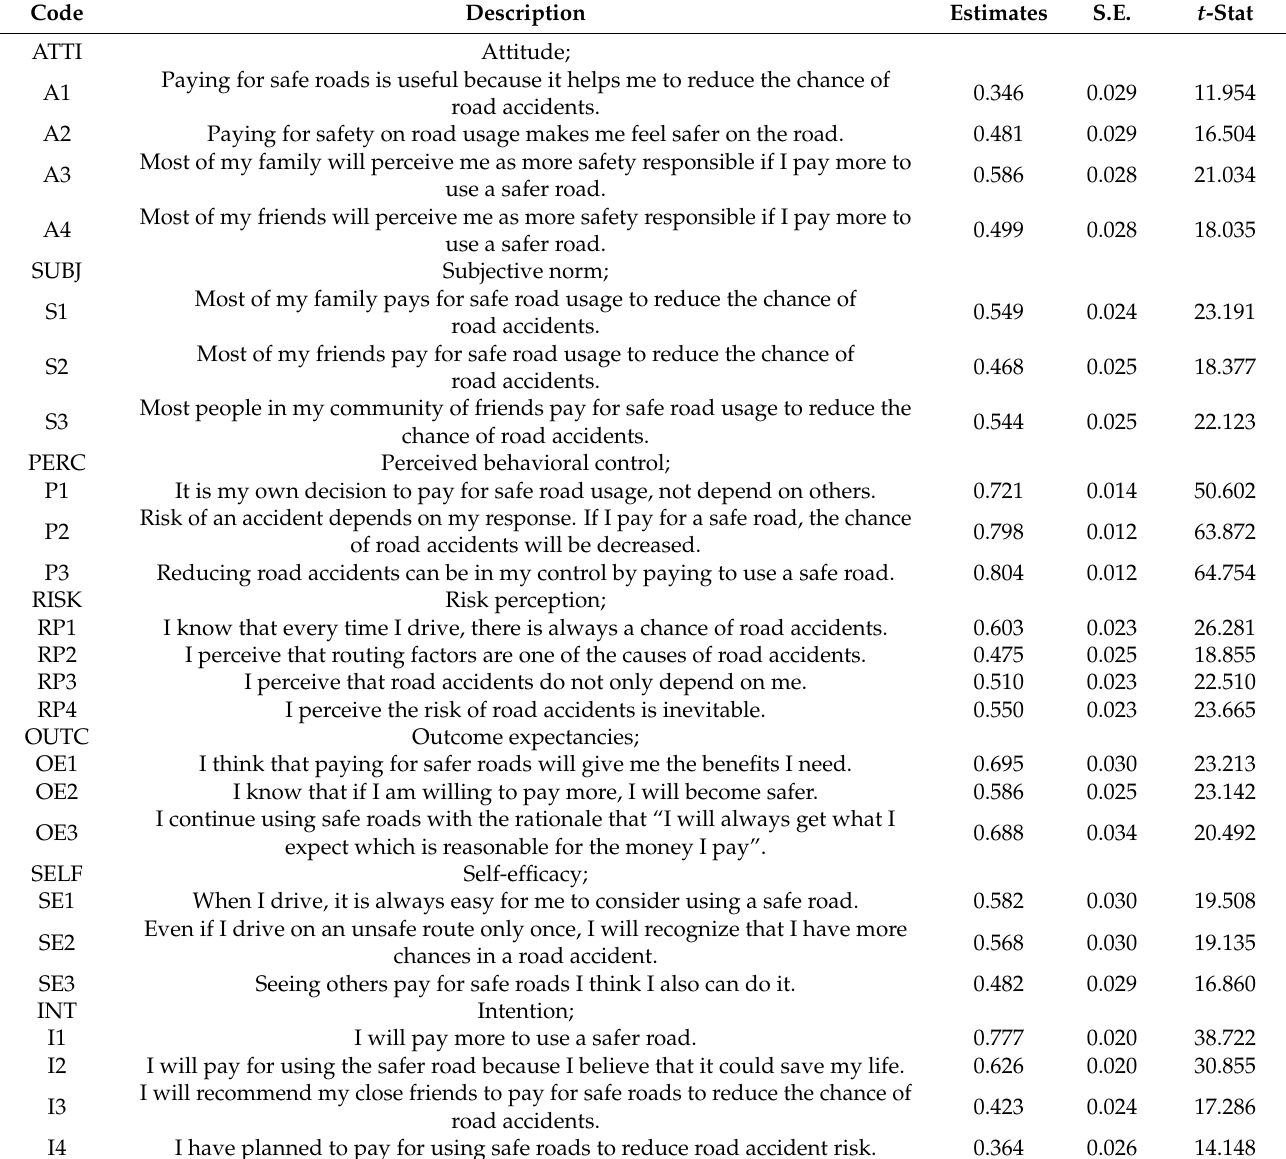
Table 4. Model results of confirmatory factor